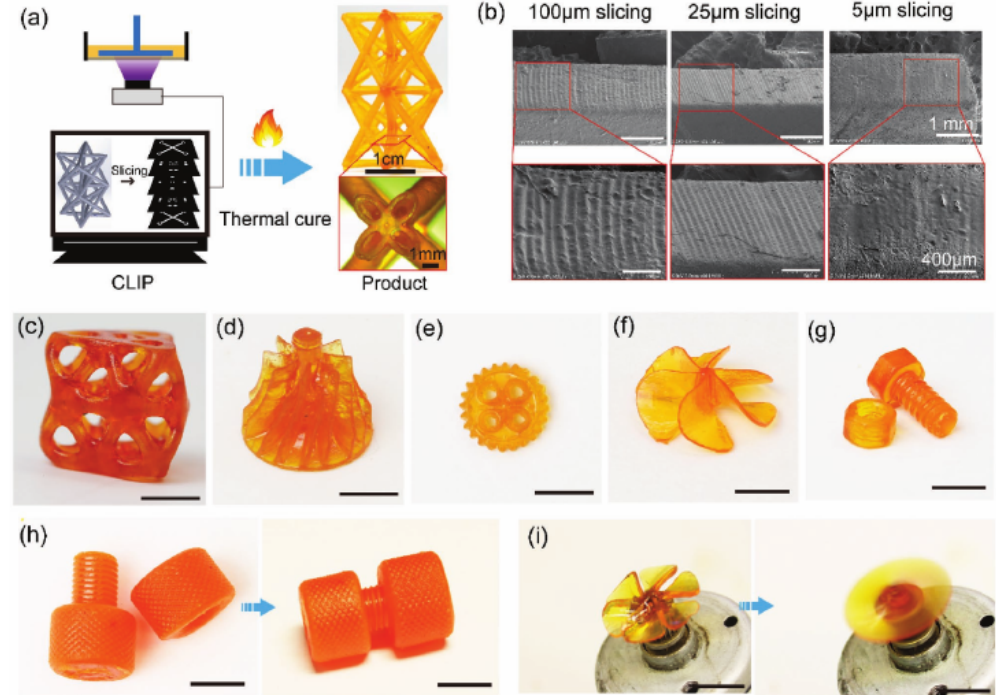
Figure 9. CLIP-assisted DLP 3D printing of interpenetrating polymer network (IPN) epoxy composites via two-stage curing and the potential applications as structural materials. ( a ) CLIP assisted fabrication of thermosets. ( b ) SEM images of patterns by CLIP-assisted fabrication at the same print speed and different slicing layer thickness. ( c – i ) Diverse architectures produced, in particular ( h ) a nut-screw set before and after assembling and ( i ) a printed fan blade driven by a motor. The scale bar is 1 cm in ( c – i ). Reproduced from [63] with the permission of Wiley.